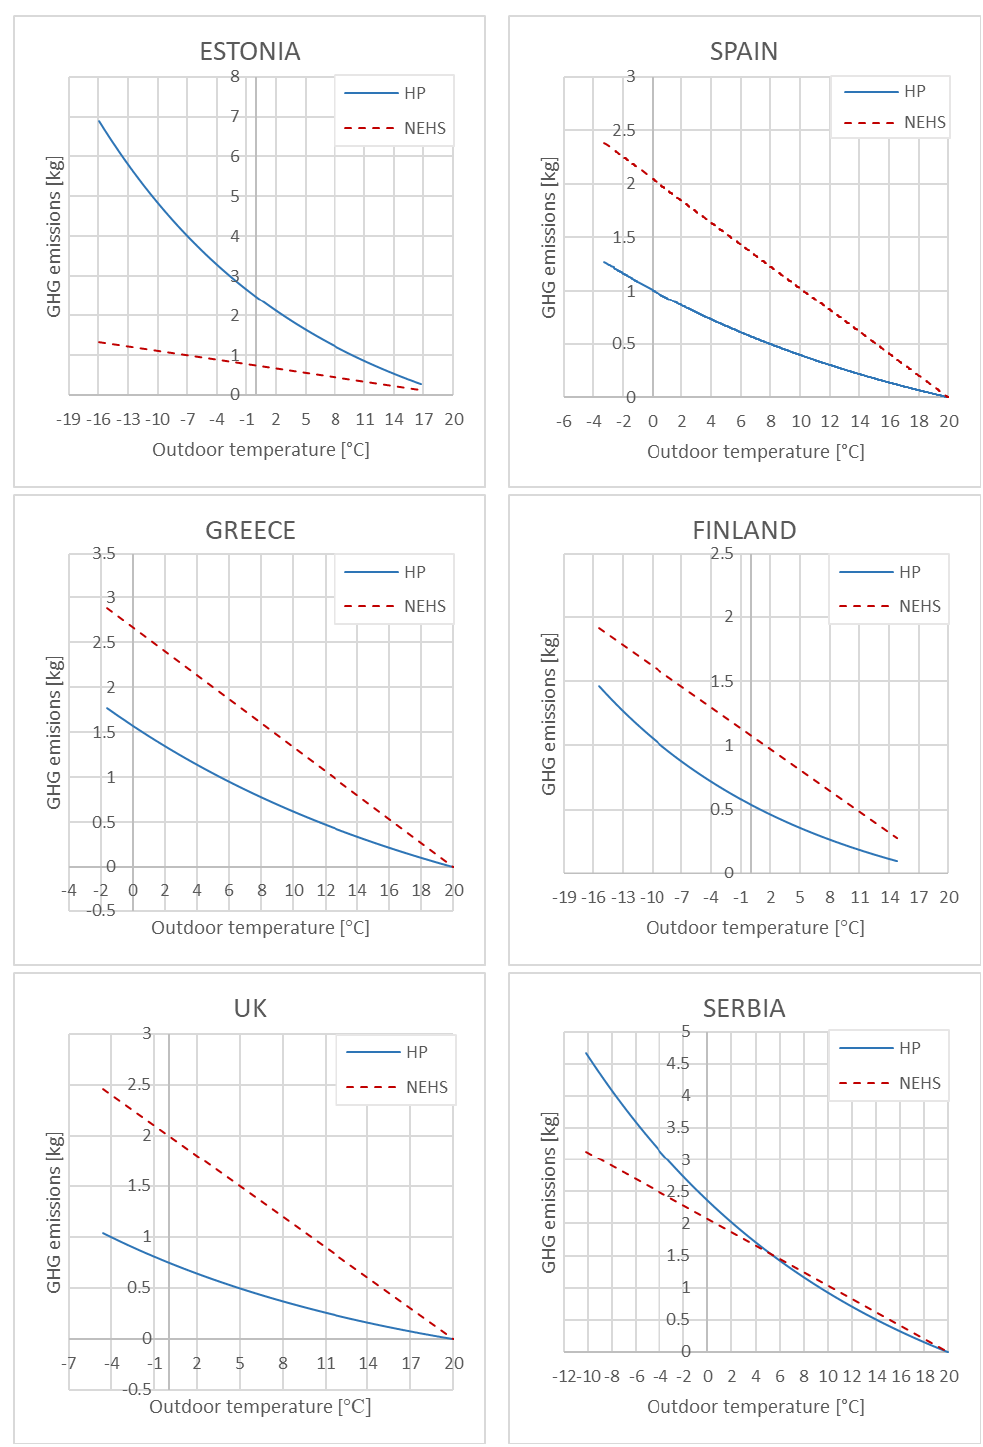
Figure 8. GHG emissions intensity of NEHS and HP versus the maximum and minimum outdoor temperature observed per country [climatic data from Copernicus database].